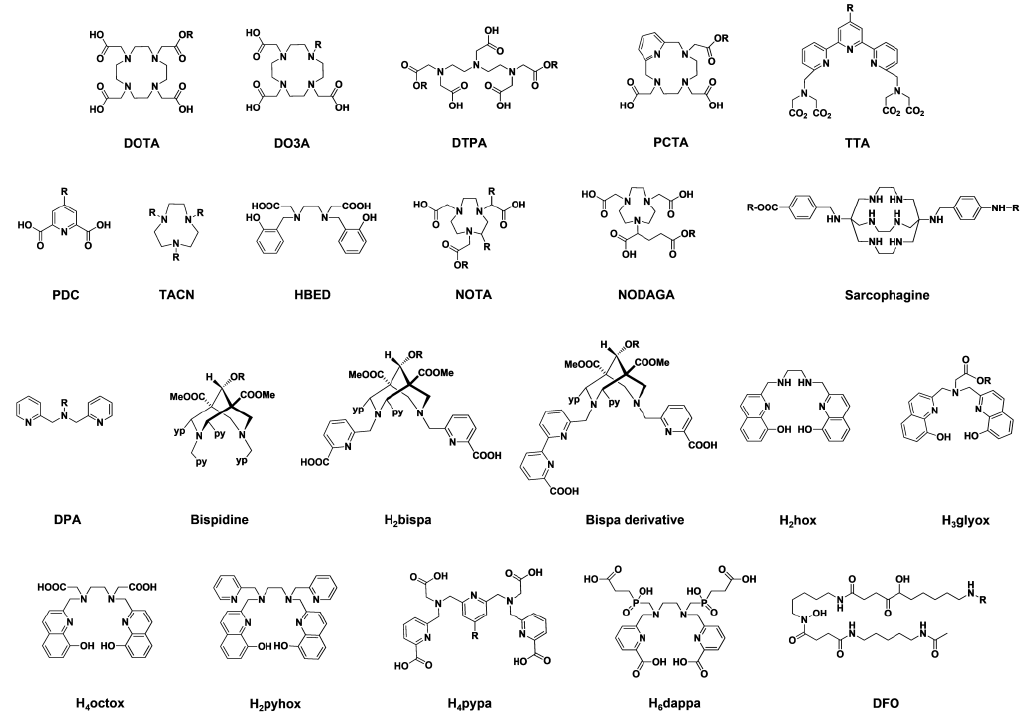
Figure 10. Representative chelators discussed in this